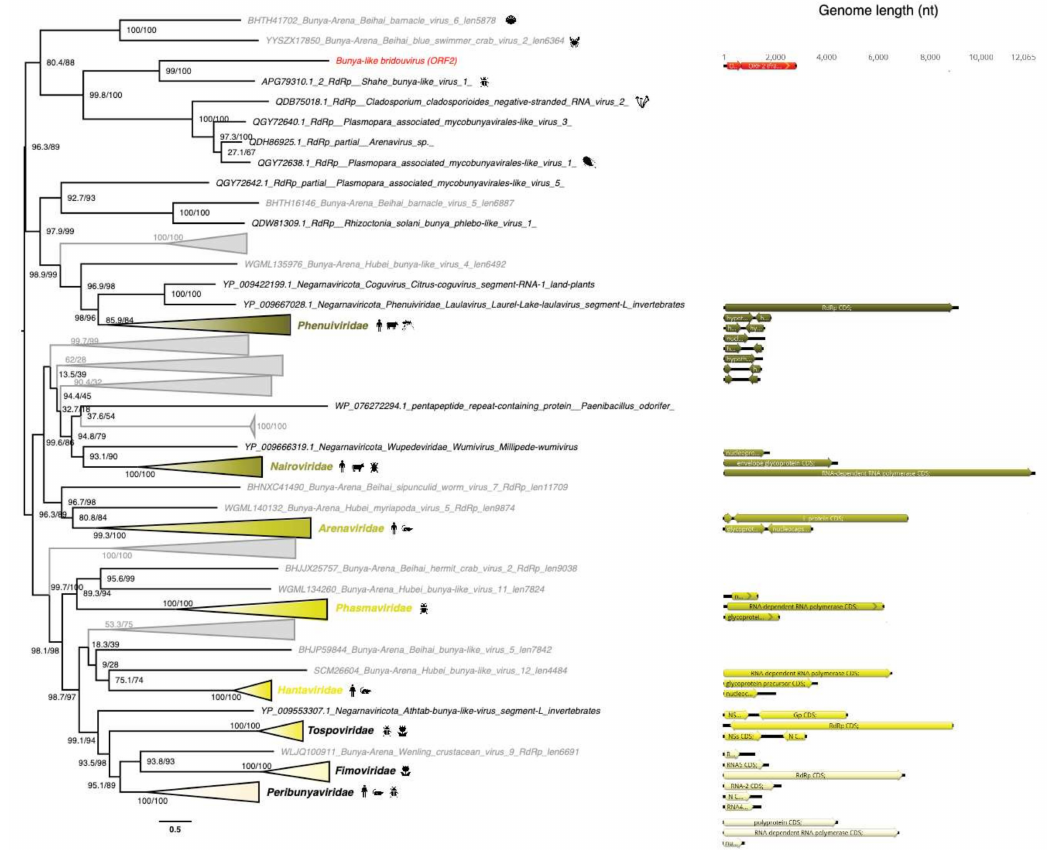
Figure 9. Phylogeny of the Bunyavirales RdRp. The bunya-like sequence identified in this study is labeled in red. Unclassified sequences from [65] are highlighted in grey. For clarity, some families and genera have been collapsed. Left, phylogenetic tree estimated using IQ-Tree with bootstrap replicates and SH-aLTR set to 1000 (values in parenthesis). Right, genomic organizations of the new viruses as well as their closest homologs and representative species from each family / genus as follows: Melon chlorotic spot virus ( Phenuiviridae ); Yogue virus ( Nairoviridae ); Latino mammarenavirus ( Arenaviridae ); Seattle orthophasmavirus ( Phasmaviridae ); Melon yellow spot virus ( Tospoviridae ); Fig mosaic emaravirus ( Fimoviridae ); Tataguine orthobunyavirus ( Peribunyaviridae ). The tree is mid-pointed rooted and branch lengths are scaled according to the number of amino acid substitutions per